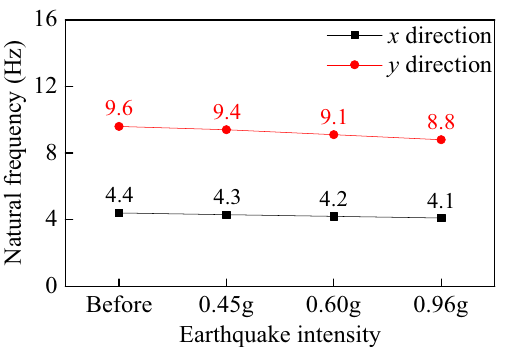
Figure 11. Fundamental frequencies of the pier specimen M-1 subject to earthquake actions.